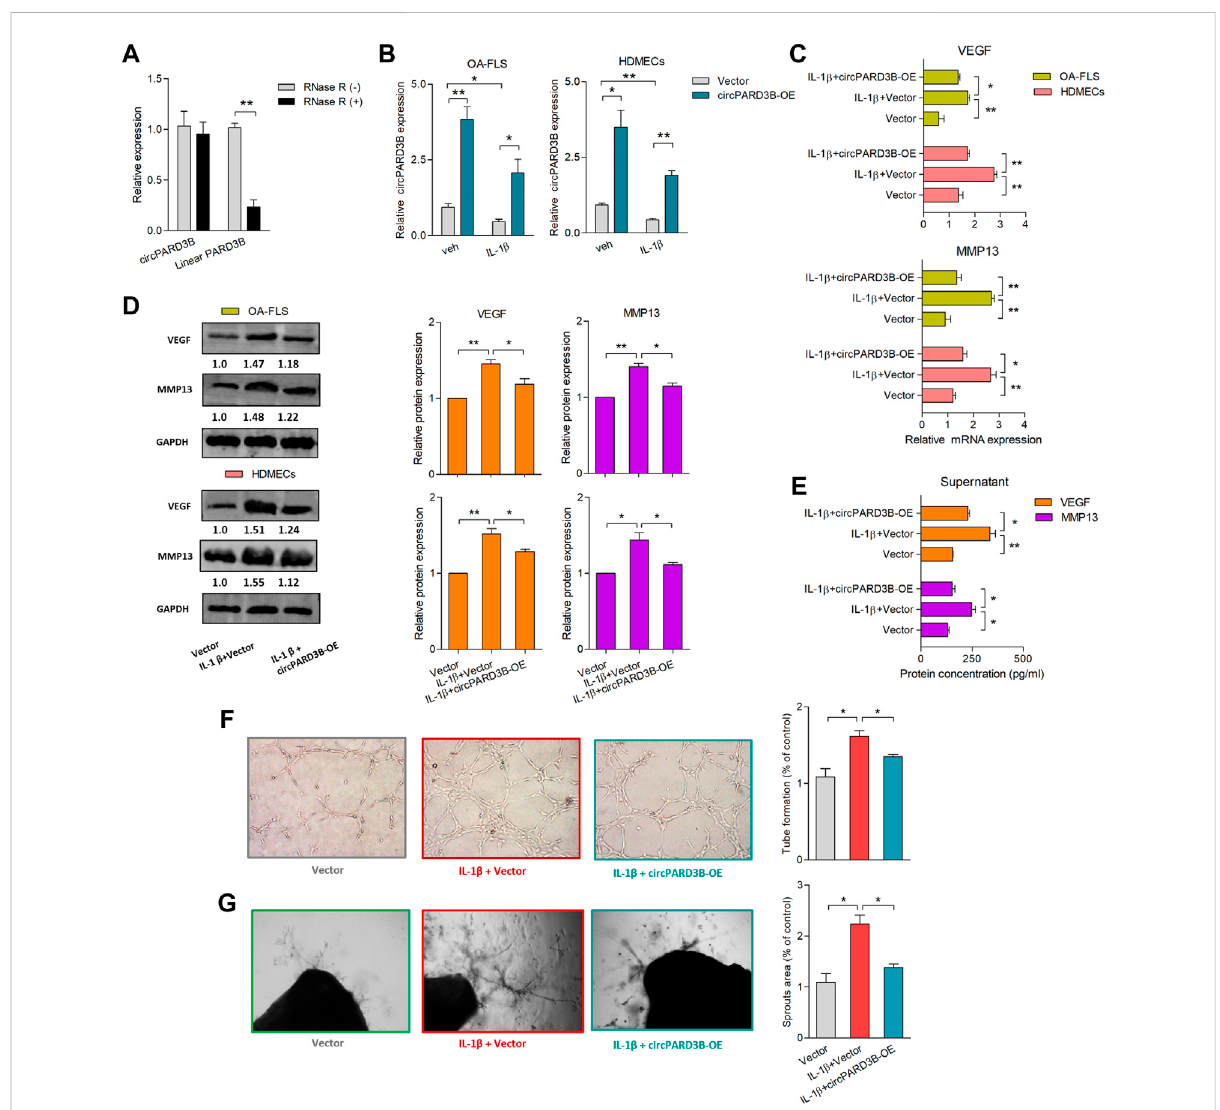
concentration of VEGF in the supernatants of the co-culture (E) was signi fi cantly upregulated after induced by IL-1 β , and then signi fi cantly downregulated via circPARD3B overexpression (n = 3). (F – G) Tube formation test (F) and ex vivo ARA of angiogenesis (G) proved the changes in the formation of capillary-like structure of HDMECs as well as microvessel sprouting with statistical signi fi cance based on the expression of VEGF in the supernatants of the OA-FLS and HDMECs co-culture (n = 3). Results are decribed with mean ± S.E.M. Veh = vehicle control. IL-1 β = 10 ng/ml * p < 0.05, ** p <